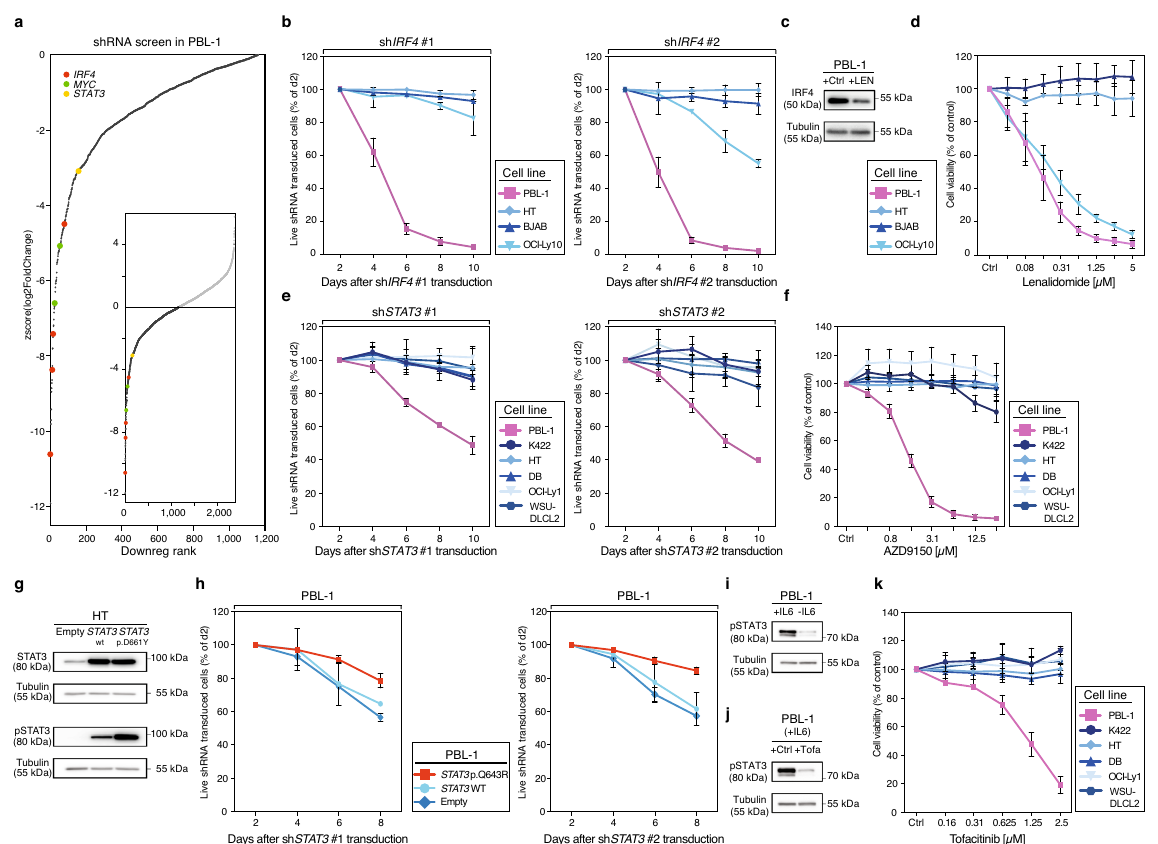
Fig. 4 Identi fi cation of molecular targets for the treatment of PBL. a shRNAs used in the shRNA library screen performed in PBL-1 cells are sorted and ranked by the corresponding z -score of log2-transformed depletion ratios after 12 days (see Supplementary Data 10 for raw read counts). shRNAs targeting IRF4 , MYC , and STAT3 are highlighted. b The graphs show the percentage of viable shRNA IRF4 #1/#2-transduced cells over time normalized to control shRNA and to day two fraction. Mean values ± standard deviations are shown of three experiments. c IRF4 protein expression by Western blot (WB) in PBL-1 cells treated with DMSO (Ctrl) or lenalidomide (LEN; 1.25 µ M) for 24 h respectively. Representative results are shown of three independent experiments. d Cell viability after treatment with indicated concentrations of lenalidomide for 5 days normalized to DMSO-treated cells. Mean values ± standard deviations are shown of three experiments. e Effect of STAT3 knockdown by two independent shRNAs on cell viability of PBL-1 cells over time. Data were shown as means ± standard deviations of three experiments. f Relative cell viability after treatment with increasing concentrations of the STAT3 antisense oligonucleotide AZD9150 for 5 days. Data were shown as means± standard deviations of three experiments. g Phosphorylated STAT3 levels determined by WB following transduction with a control plasmid (empty), wild-type (wt) STAT3 , and p.D661Y STAT3 cDNA in HT cells. Representative results are shown of three independent experiments. h Exogenous expression of the p.Q643R STAT3 cDNA rescues PBL-1 cells from STAT3 shRNA-mediated toxicity. In contrast, a control plasmid (empty) or wild-type (wt) STAT3 did not induce a rescue of STAT3 shRNA-transduced PBL-1 cells. Data were shown as means ± standard deviations of two experiments. i Phosphorylated STAT3 levels determined by WB in PBL-1 cells supplemented with or without IL-6 (5 ng/ml) or j treated with the pan-JAK inhibitor tofacitinib (0.5 µ M) for 4 h. Representative results are shown of three independent experiments. k The pan-JAK inhibitor tofacitinib decreases the cell viability of PBL-1 cells. In contrast, DLBCL control cell lines are unaffected by tofacitinib treatment. Data were shown as means ± standard deviations of three independent experiments. Source data for Fig. 4b – k are provided as a Source Data fi